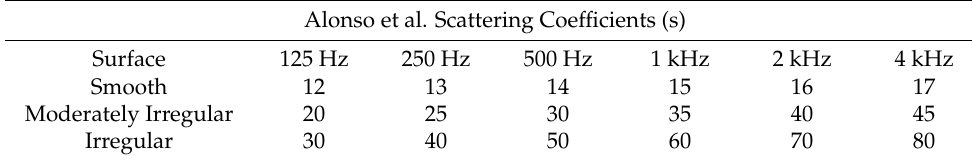
Table 3. Recommended scattering coefficients